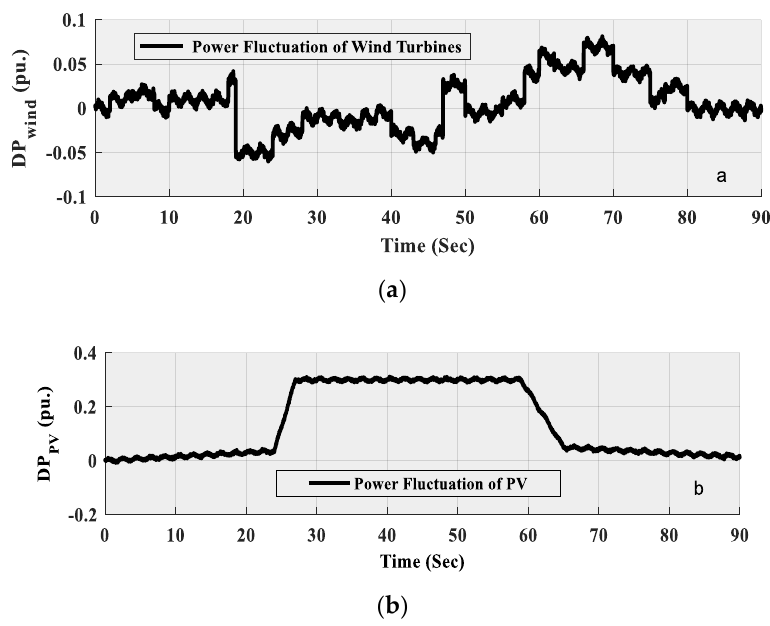
Figure 6. Power fluctuation, ( a ) wind power generator (WPG), ( b ) photovoltaic (PV).